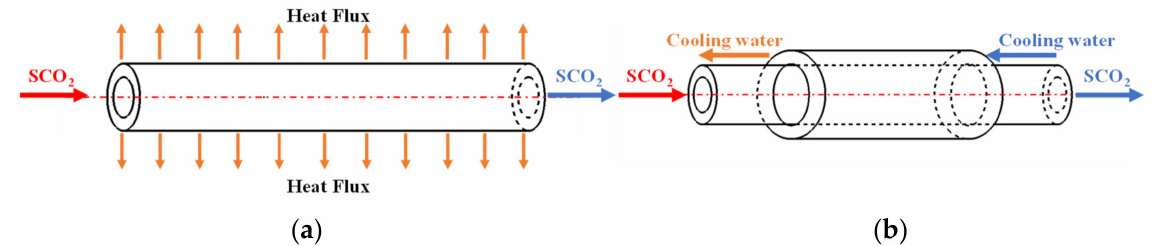
Figure 13. The typical computational domains and boundary conditions. ( a ) Constant heat flux boundary condition. ( b ) Conjugated heat transfer boundary